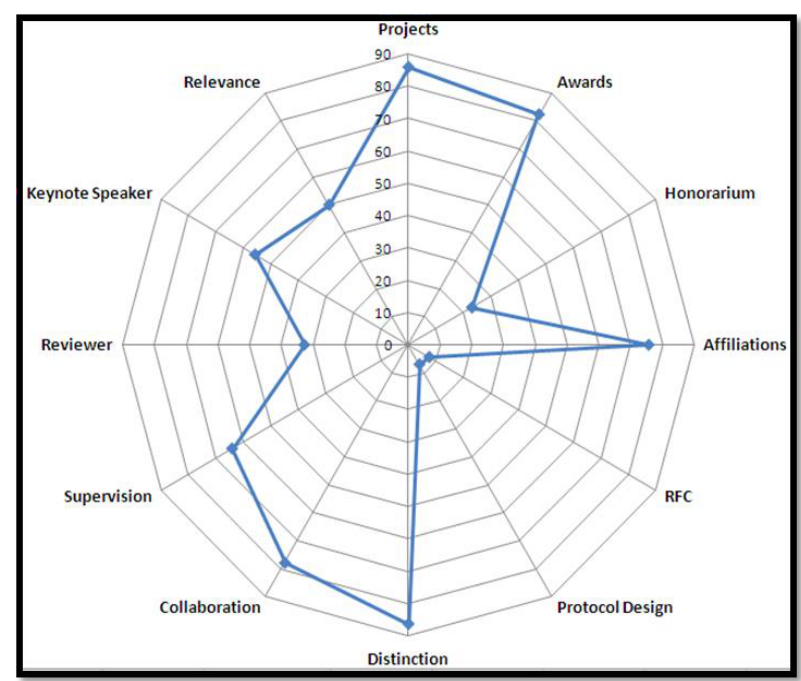
Figure 3. F-Measure for web weights used in the